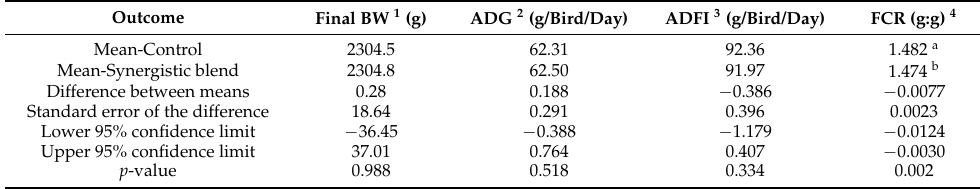
Table 3. Results of the meta-analysis on growth performance for the overall study period.